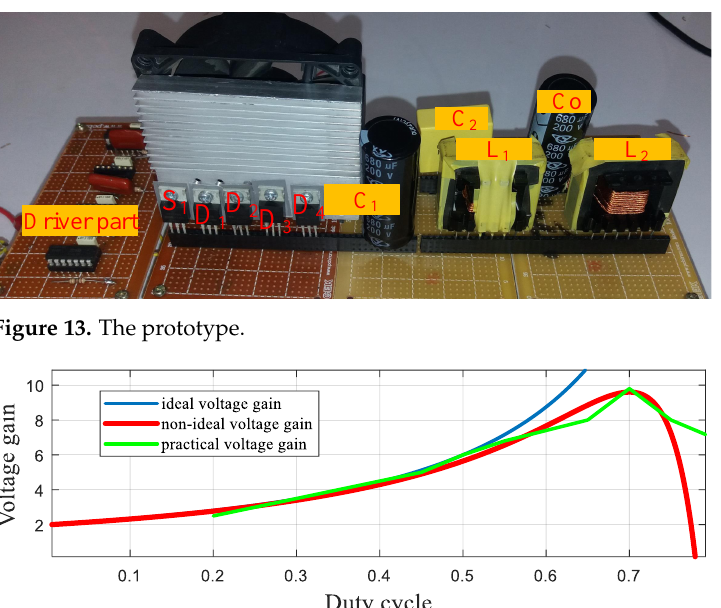
Figure 12. The extracted current waveform of the semiconductor devices.